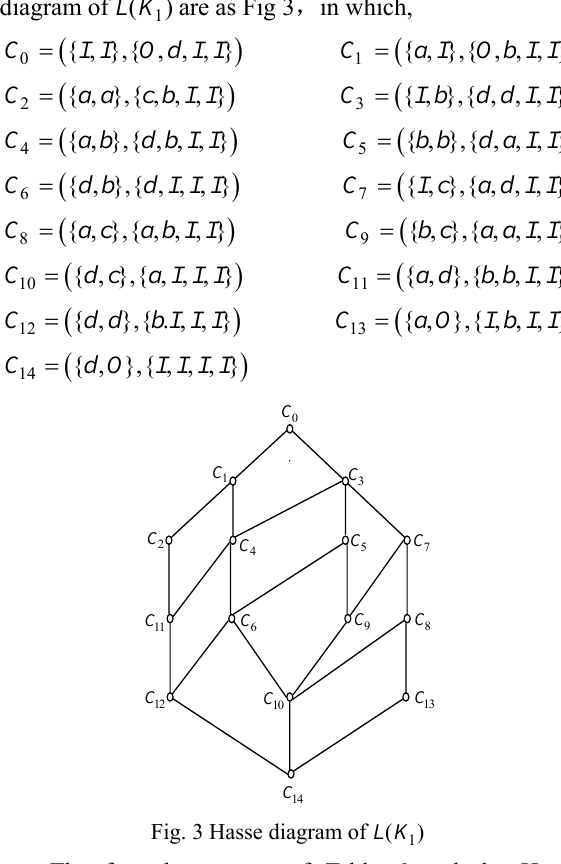
Table 5 ． A lattice-valued formal context